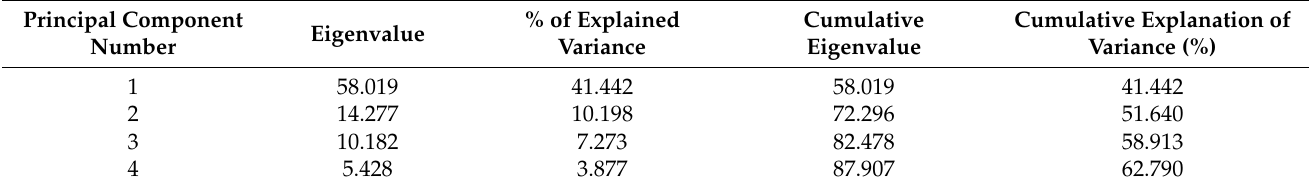
Table 1. Results of the principal component analysis of the set of ND LF recorded at 140 water gauges on 83 rivers in Poland in 1951–2020.